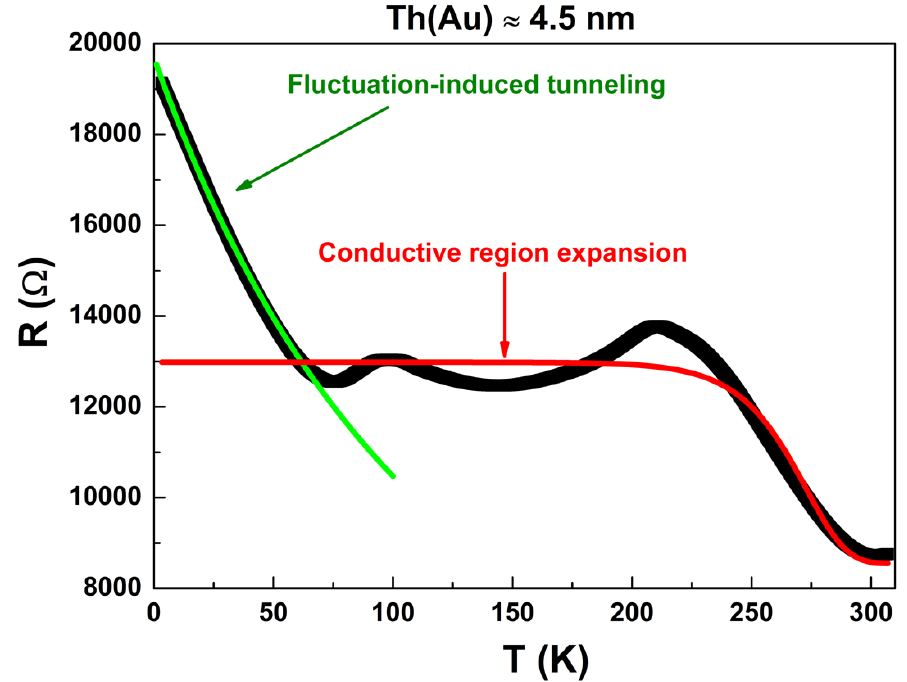
Figure 3. Modeling of the DC experimental data obtained for the thinnest Au film (4.5 nm). The R - T dependence (black dots) could be reproduced with the fluctuation-induced tunneling model below 70 K (green curve, best fit using Equation (2)) and with a phenomenological model that assumes an expansion of the conductive region from 300 to 200 K (red curve, best fit using Equation (4)). Above 70 K, instead, the curve substantially flattened out with some